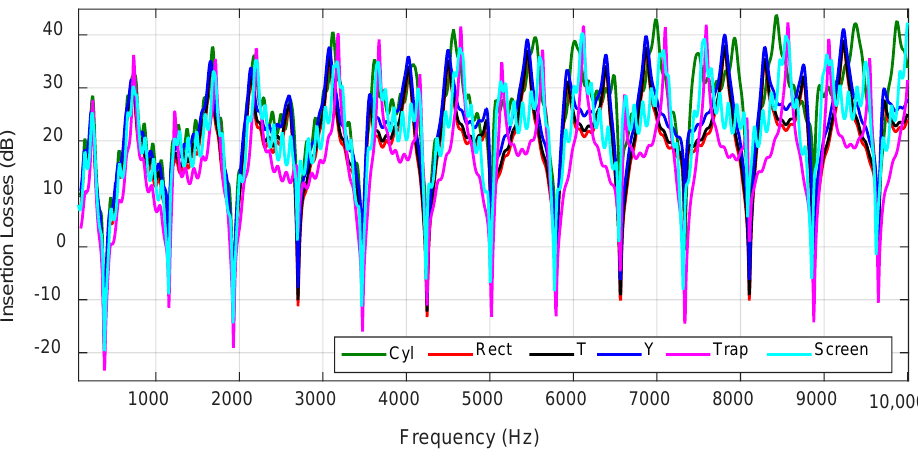
Figure 12. IL in Configuration 1 ‘Car–Person’ for single caps and a single screen barrier as a reference.